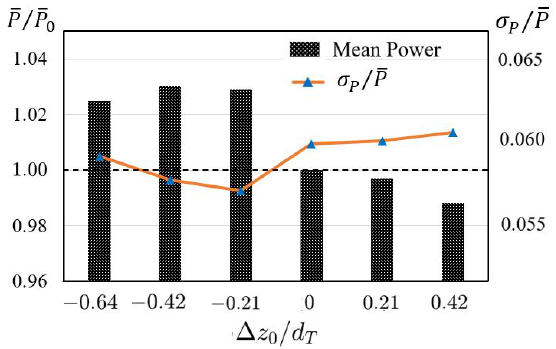
Figure 11. Mean power output ( P ) and intensity of the power output fluctuations ( σ P / P ) for the backward- and forward-facing step cases and flat